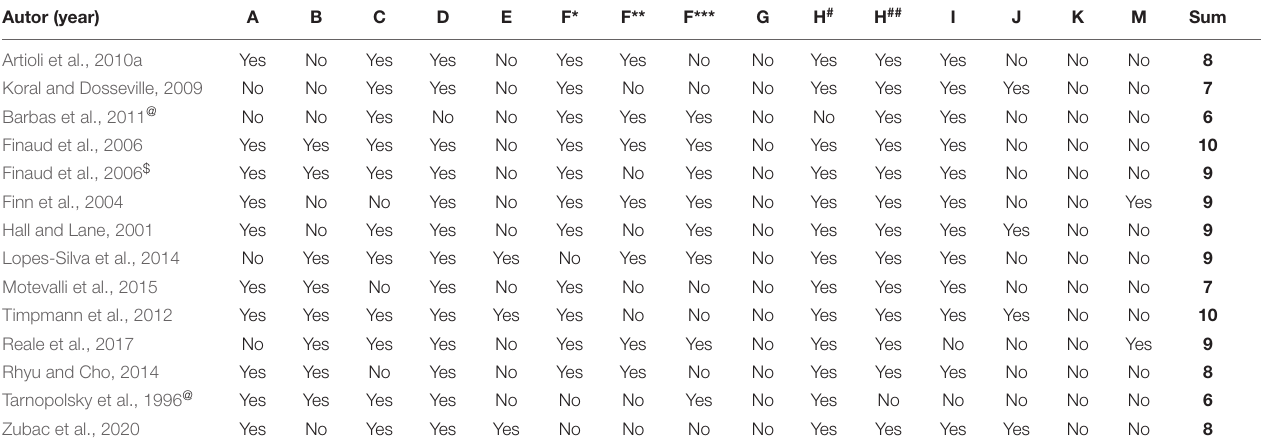
TABLE 1 | Quality analysis results according to TESTEX.